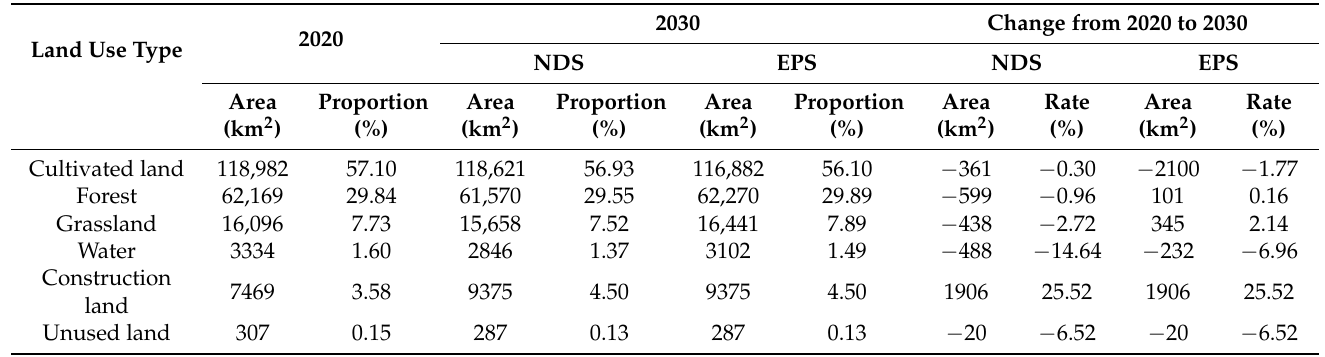
Table 6. Area of each region in 2030 under the concept of environmental preservation and natural development, and its ratio to 2020.